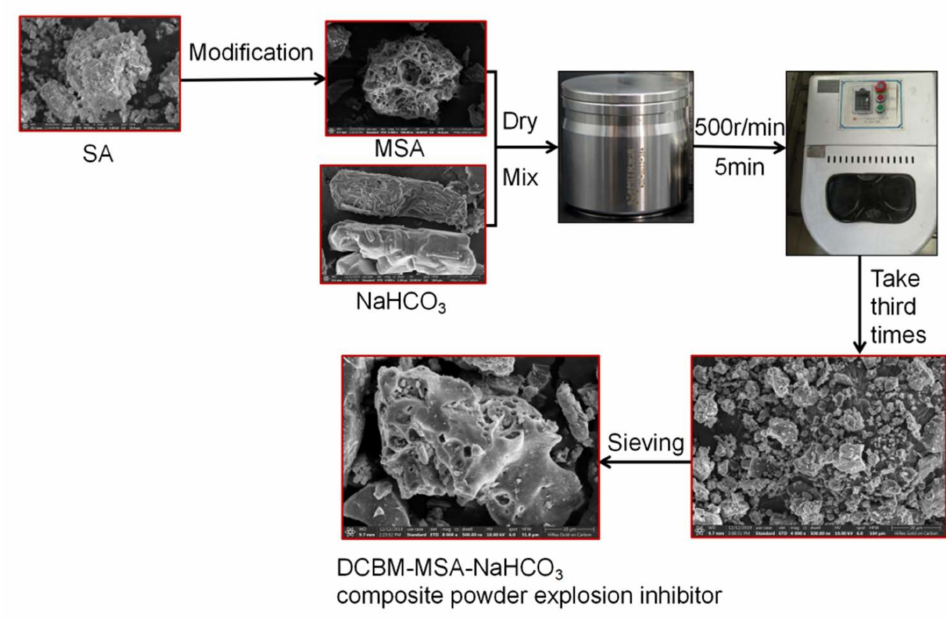
Figure 2. The WCBM compounding